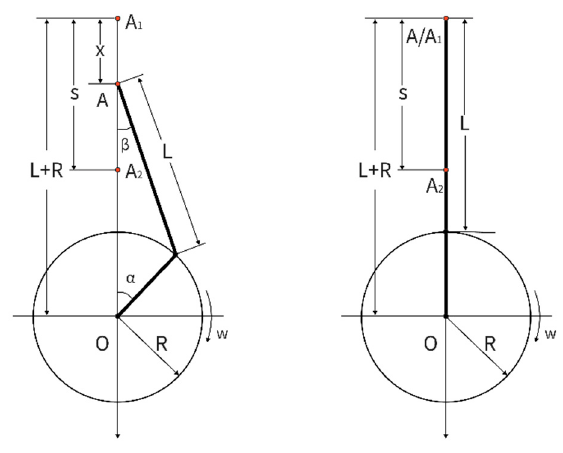
Figure 11. Simpli fi ed side view of crankshaft system . Figure 11. Simplified side view of crankshaft